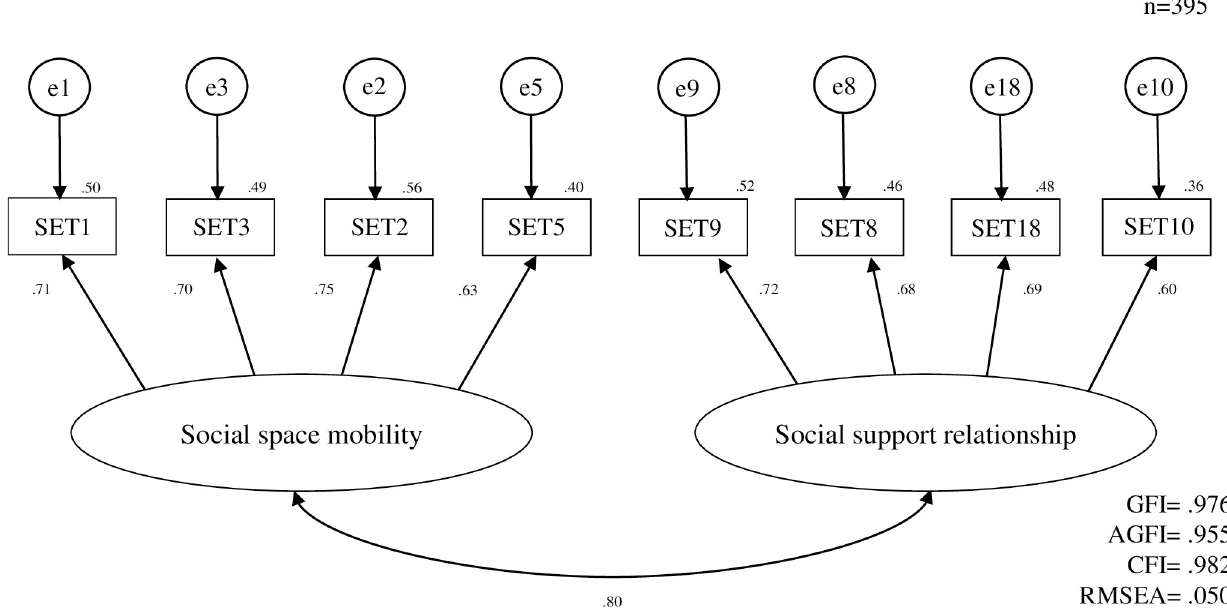
Fig 1. Confirmatory factor analysis of the “social contact self-efficacy Scale for Third Agers (SET)”.